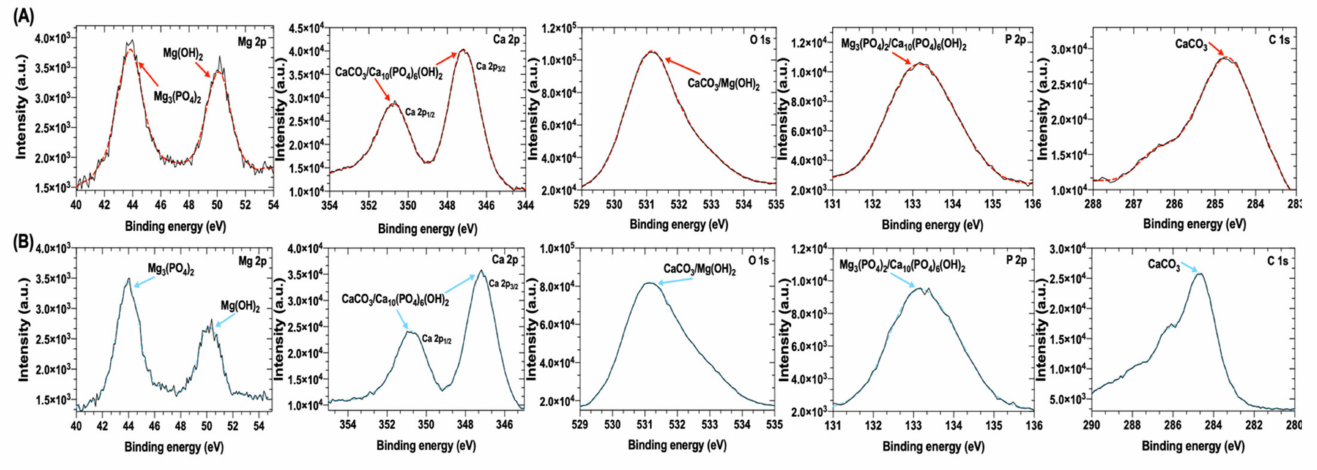
Figure 5. XPS spectra of the layers grown on ( A ) Mg and ( B ) Mg-Ca0.3 surfaces after exposure to Hank’s solution for 14 days (at 37 ◦